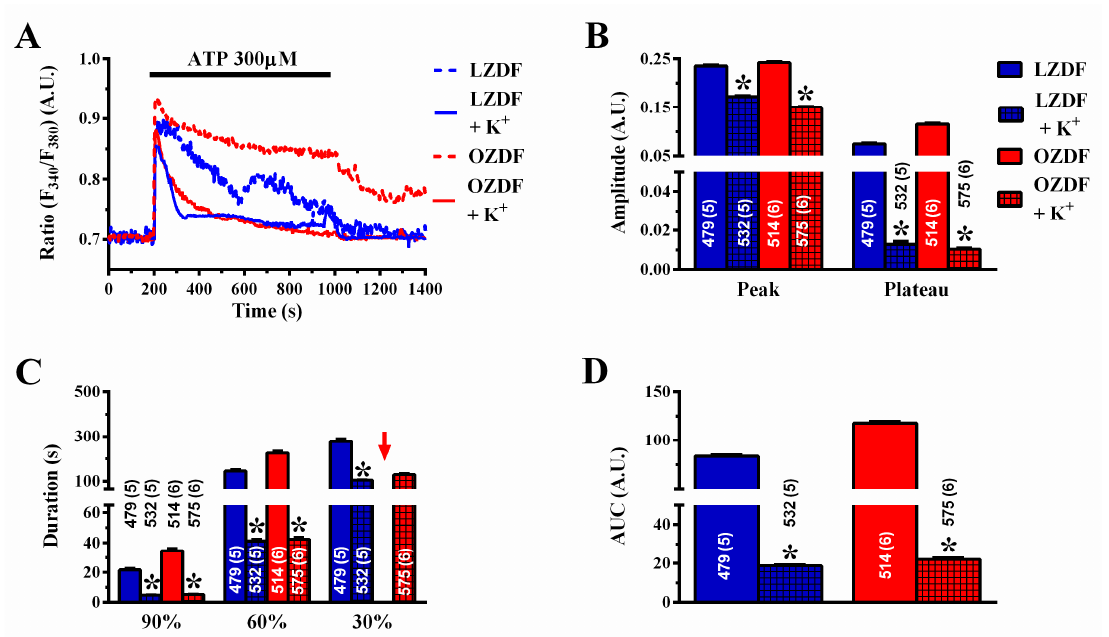
Figure 13. High extracellular KCl affects the Ca 2+ response to ATP in obese Zucker diabetic fatty rats. ( A ) Representative recordings of the Ca 2+ response to 300 µM ATP in the absence or presence of high-KCl (90 mM) extracellular solution in native aortic endothelium of LZDF and OZDF rats. ( B ) Mean ± SE of endogenous Ca 2+ release and SOCE amplitude recorded in native aortic endothelium of LZDF and OZDF rats challenged with 300 µM ATP in the absence or presence of high-KCl extracellular solution. The asterisk indicates p < 0.05. ( C ) Mean ± SE of the duration of the two distinct components (i.e., endogenous Ca 2+ release and SOCE) of the Ca 2+ response to 300 µM ATP in native aortic endothelium of LZDF and OZDF rats in the absence or presence of high-KCl extracellular solution. The asterisk indicates p < 0.05. Red arrows indicated that the Ca 2+ signal failed to reach the clearing rate indicated in the graph in OZDF rats. ( D ) Mean ± SE of the AUC of the two distinct components (i.e., endogenous Ca 2+ release and SOCE) of the Ca 2+ response to 300 µM ATP in native aortic endothelium of LZDF and OZDF rats in the absence or presence of high-KCl extracellular solution. The asterisk indicates p < 0.05, Mann-Whitney test.